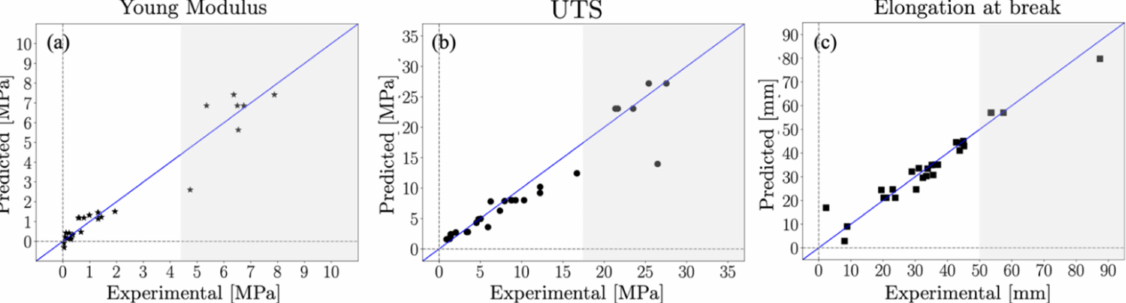
Figure 6. Learning results of ( a ) Young’s modulus ( σ = 0.89) ( a , b ) ultimate tensile strength ( σ = 2.78) and ( c ) elongation at break ( σ = 4.09). The diagonal blue line represents the position with zero error and the gray shaded area corresponds to regions in the film composition space with the smallest number of fabricated